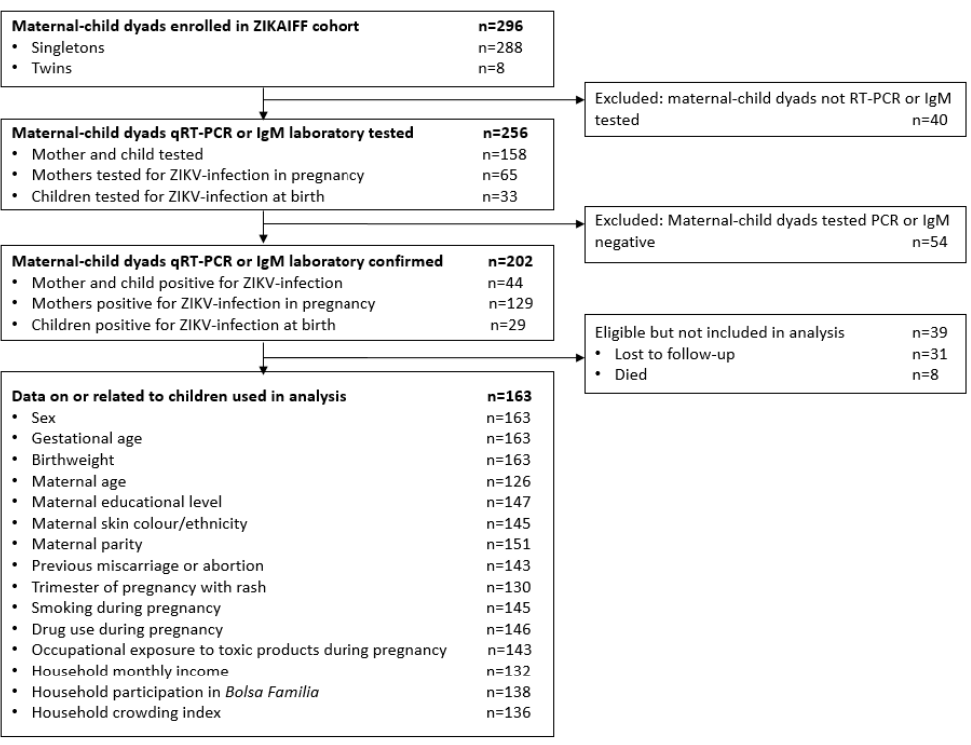
Figure 2. Flow diagram for cohort selection based on study inclusion and exclusion criteria.